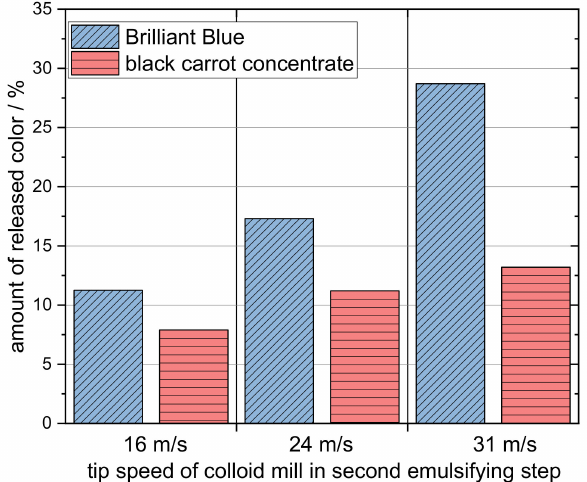
Figure 7. Relative release of di ff erent markers from a double emulsion formulation. W1 / O / W2 phase composition: W1: aqueous 0.35 wt % NaCl solution; O: canola oil with PGPR; W2: aqueous polyvinyl alcohol solution. The emulsions were prepared with three di ff erent shear rates in the second